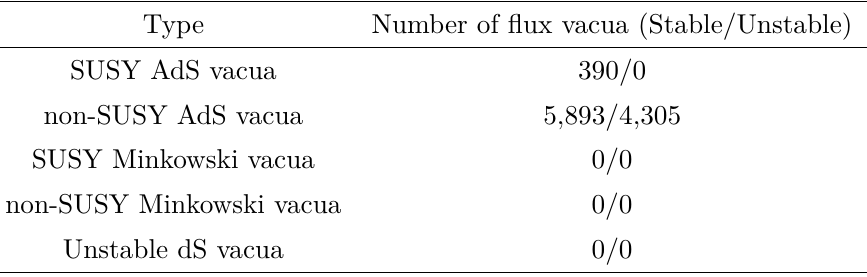
Table 2 . The number of vacua in the anistropic